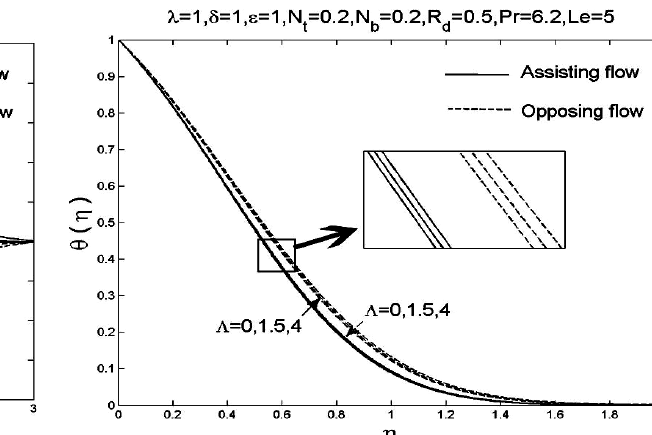
Fig. 11. The effect of the constant magnetic/porous medium pa- rameter Λ on the temperature profiles, ( ) θη